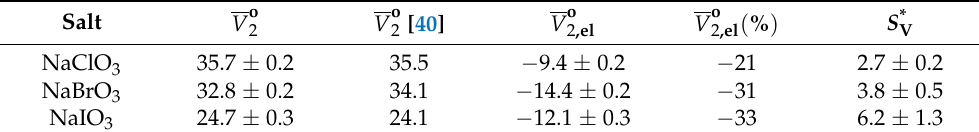
Table 1. Standard partial molar volumes V o 2 calculated according to Equation (A4) and compared with the values reported in Ref. [40], standard electrostrictive molar volumes V o 2,el for each investigated salt at 25 ◦ C expressed in (cm 3 · mol − 1 ) according to Equation (A6), and S ∗ fitting the data according to Equation (A5).